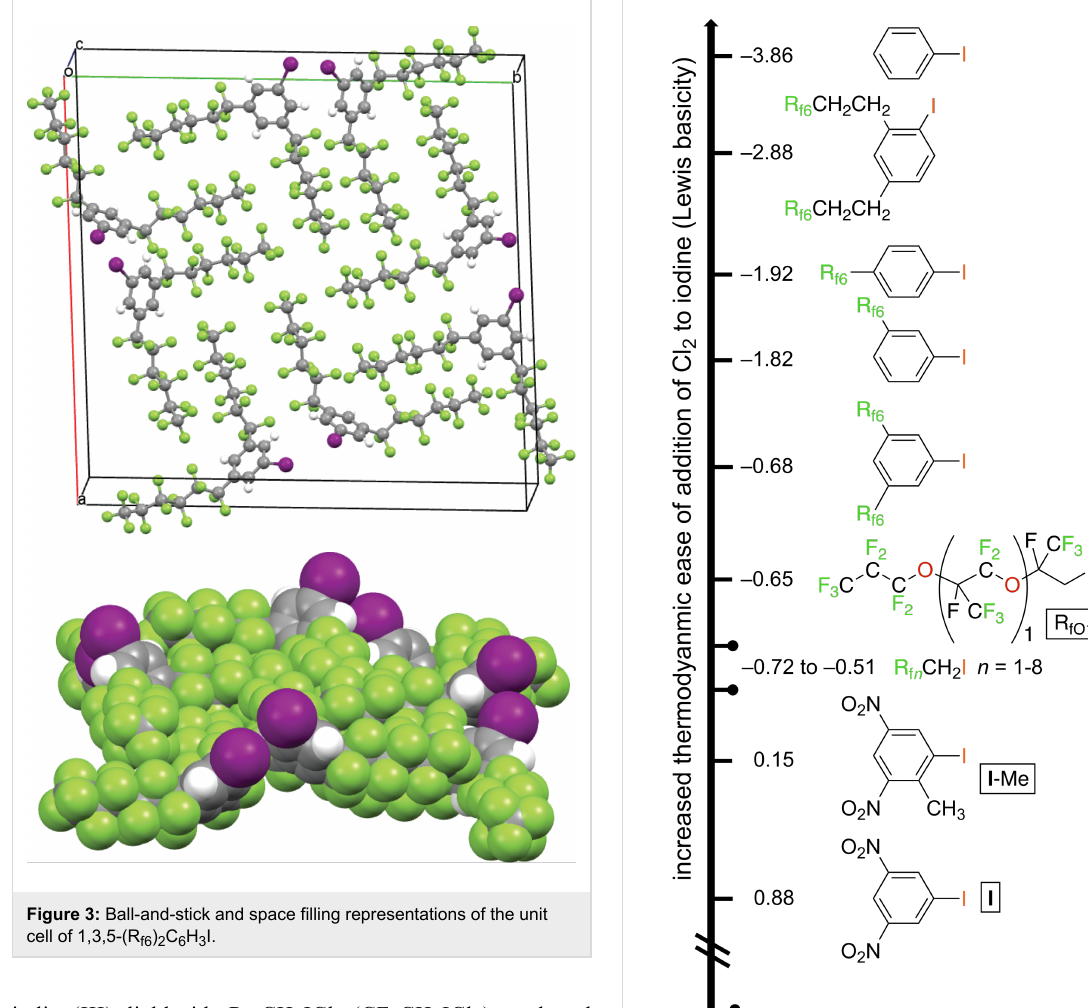
iodine(III) dichloride R f1 CH 2 ICl 2 (CF 3 CH 2 ICl 2 ) to phenyl